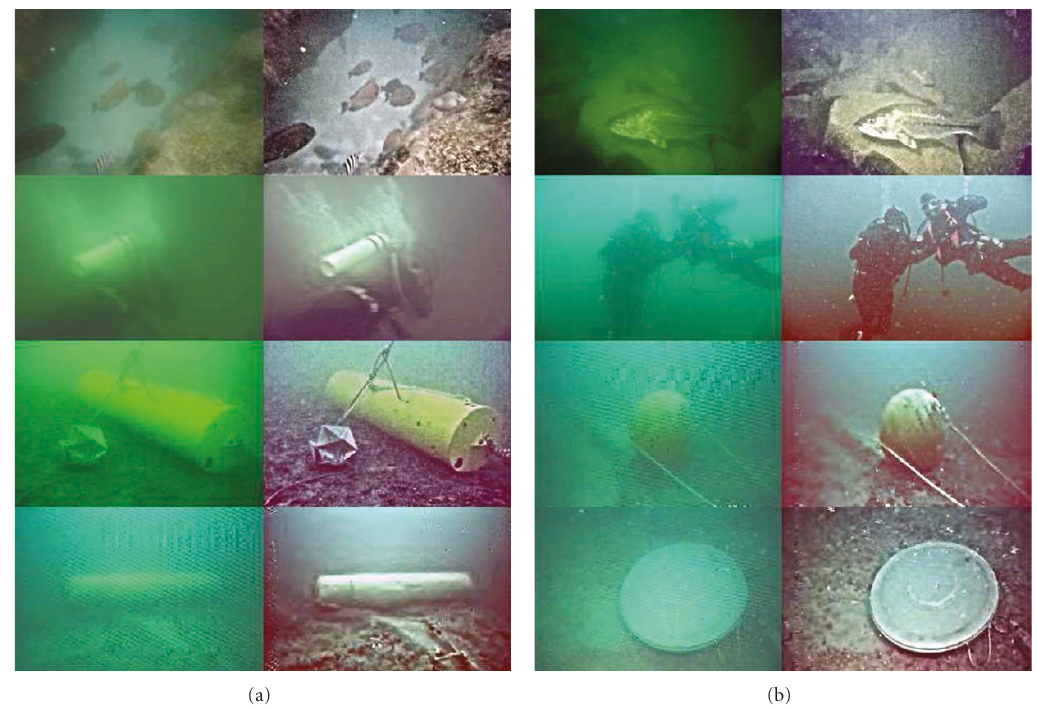
Figure 6: Pairs of images before (a) and after (b) Bazeille et al.’ processing. Image courtesy of Bazeille et al.